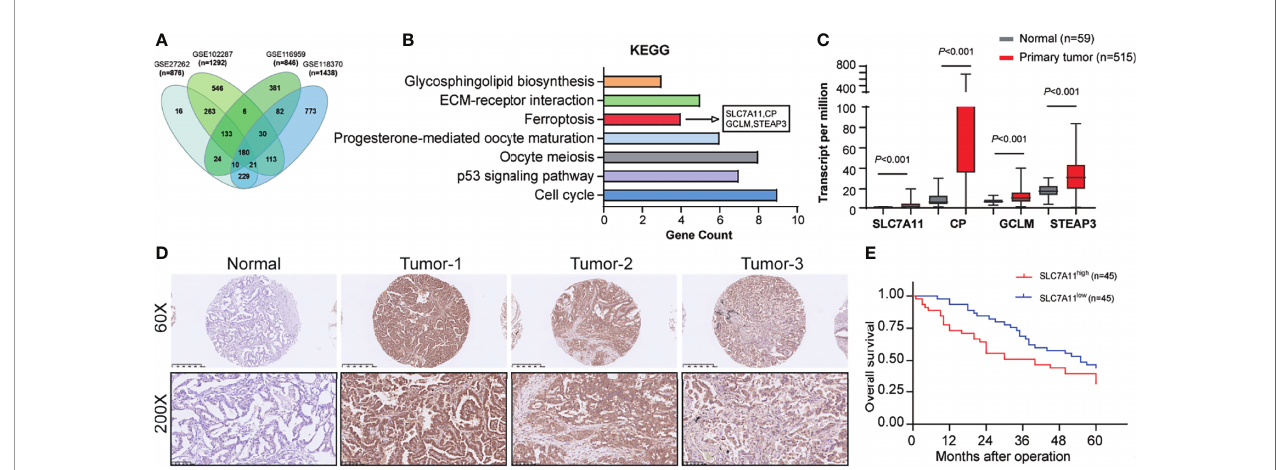
FIGURE 1 | SLC7A11 expression in NSCLC tissues and its clinical signi fi cance. (A) Bioinformatic interrogation of Gene Expression Omnibus (GEO) datasets. (B) The cellular processes that were positively correlated with NSCLC according to KEGG analysis. (C) Expression level of SLC7A11, CP, GCLM, and STEAP3 in the TCGA-LAUD database. (D) The SLC7A11 protein levels in NSCLC patients were analyzed by immunohistochemistry. (E) Kaplan – Meier overall survival (OS) curves according to SLC7A11 expression